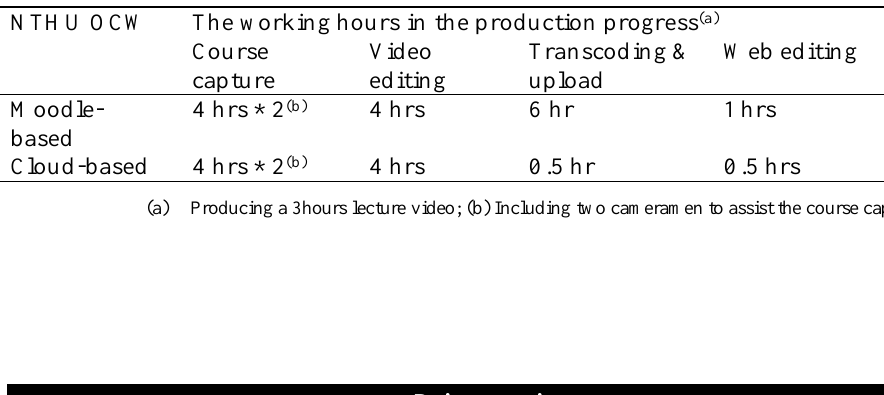
Working Hours in the Production Process with Moodle and Cloud-Based